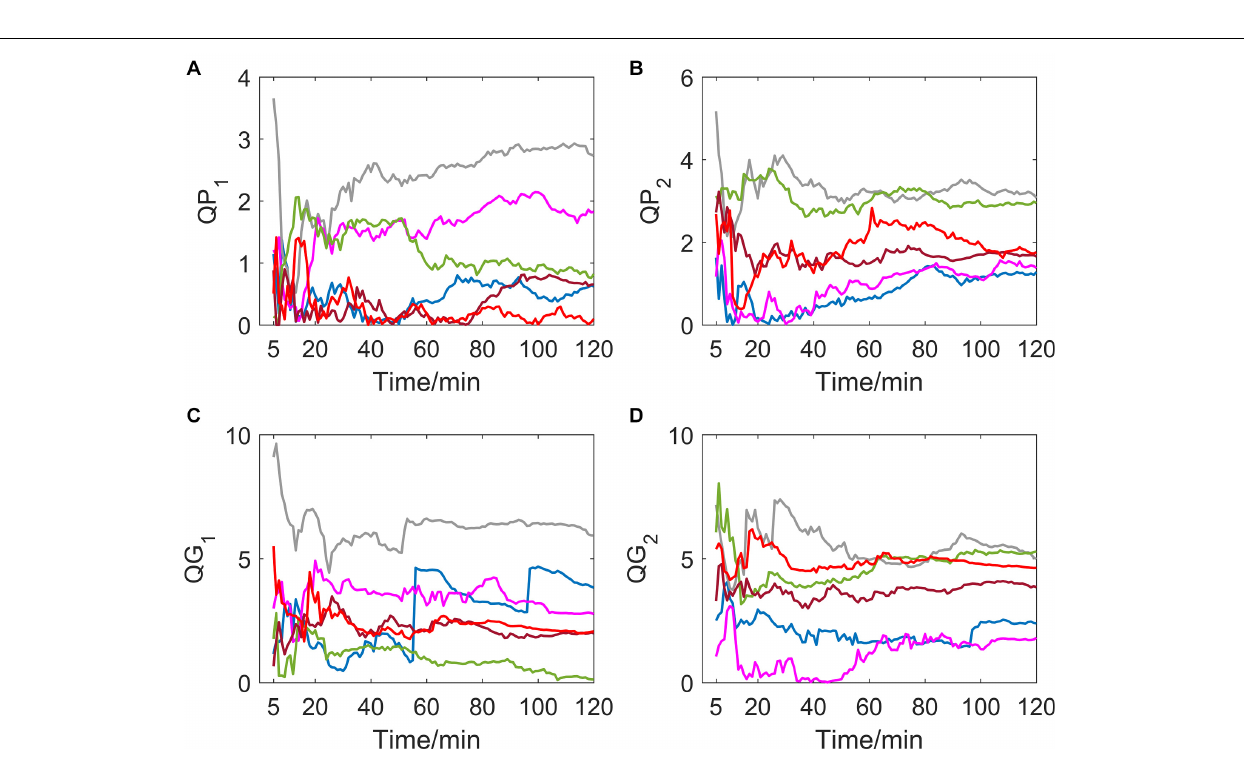
Frontiers in Physiology |